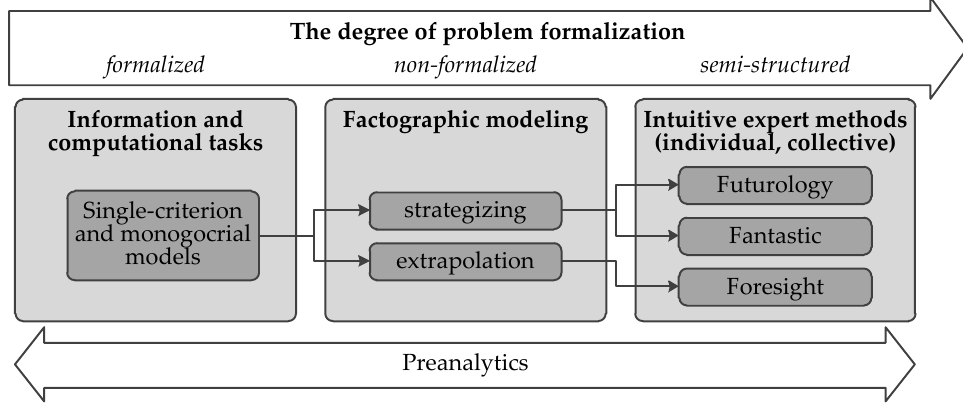
Figure 1. Methods of foresight for predicting the future.